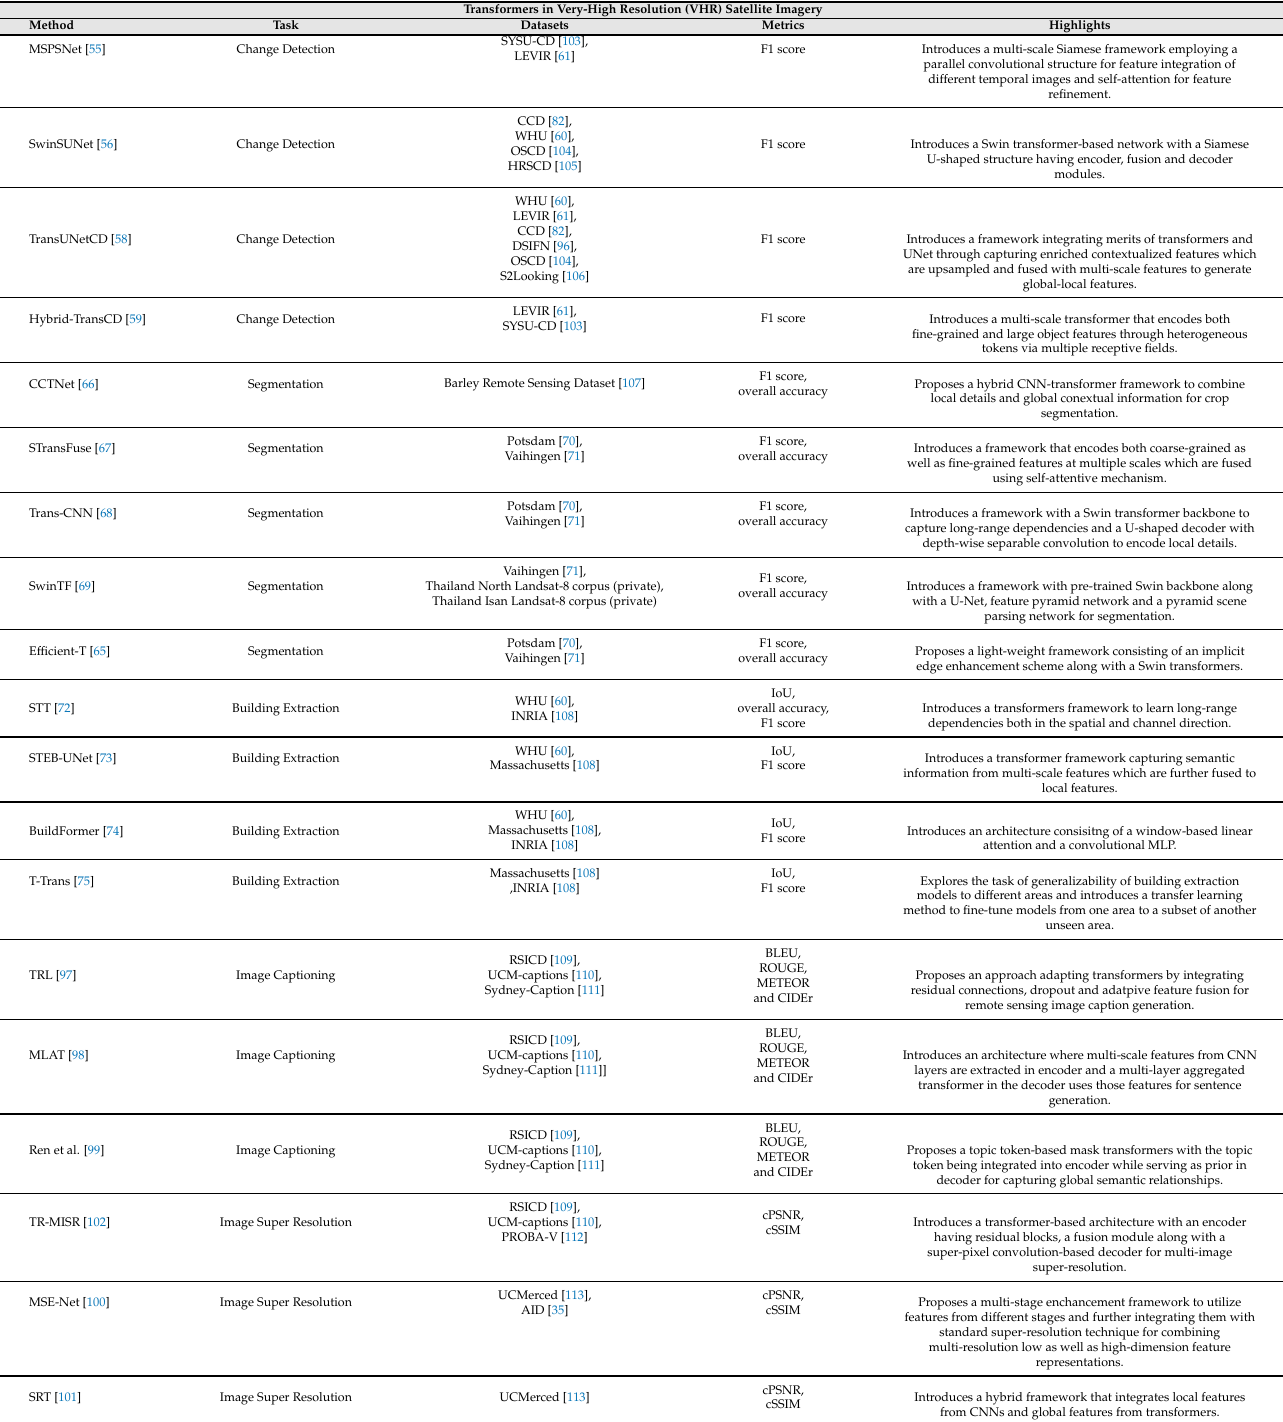
Table 6. Overview of transformer-based approaches in VHR remote sensing imaging. Here, we highlight transformer-based methods for different VHR remote sensing